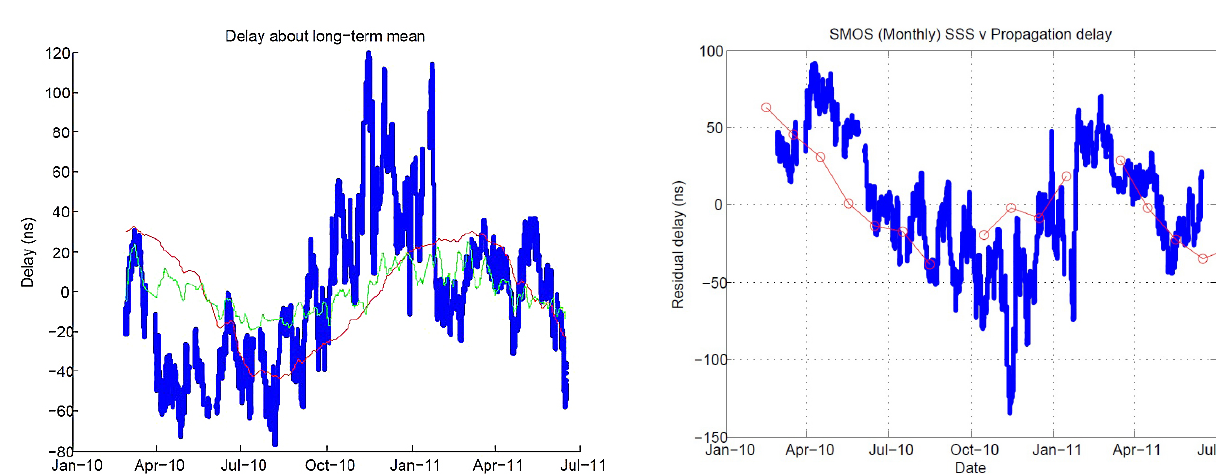
Figure 2. Measured Loran-C delay variations (blue) and modelled SST (red) and atmospheric delays (green). Removing the atmo- spheric and SST delays from the measured delay will leave the de- lay due only to sea surface salinity (SSS).